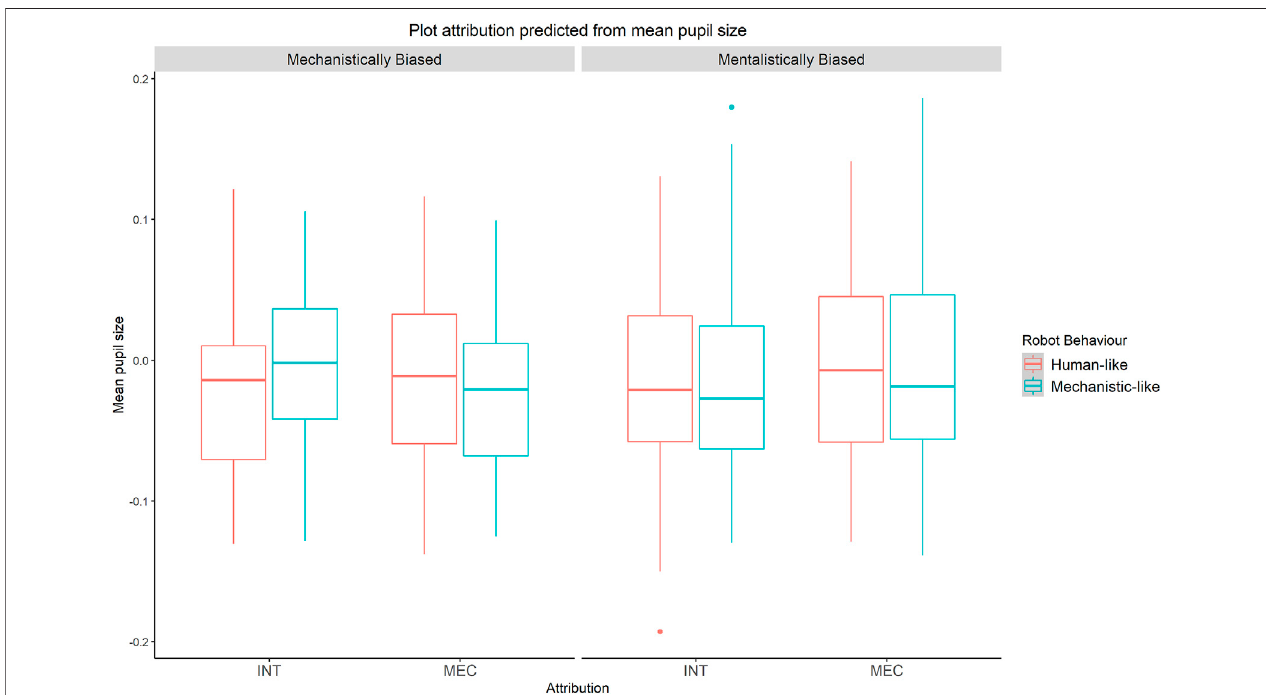
FIGURE4| GLMMonthemechanisticgroup( N (cid:2) 9)andthementalisticgroup( N (cid:2) 12).Themechanisticbiasgroupshowstheinteractioneffectbetweenattribution and mean pupil size. No statistically signi fi cant effect on attribution and pupil size in the mentalistic bias group.